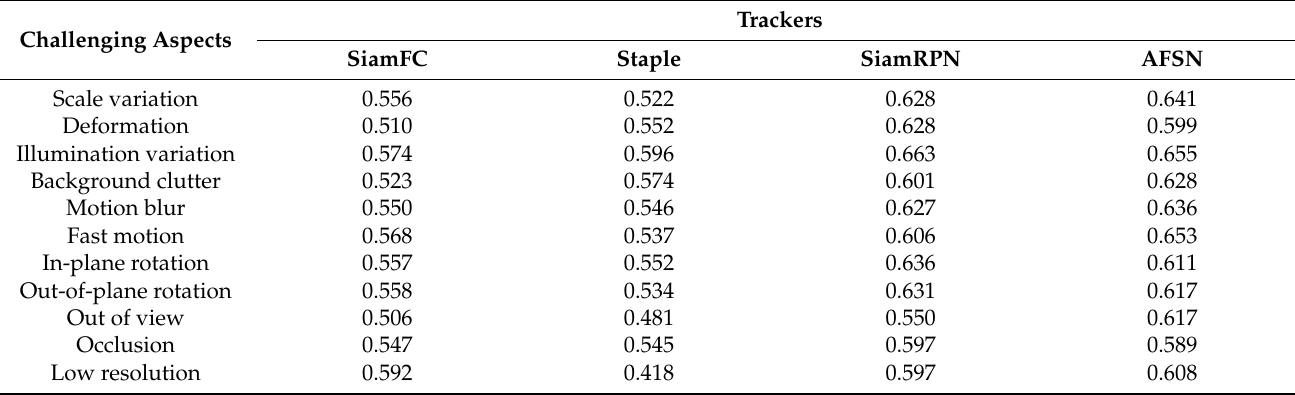
Figure 7. Comparisons on OTB100. ( a ) Success plots and ( b ) precision plots. Our AFSN achieves the best results. AFSN: Anchor-Free Siamese Network; SiamRPN: Siamese Region Proposal Network; SiamFC: Fully-Convolutional Siamese Networks; LCT: Long-term Correlation Tracking; CFNet: Correlation Filter Network; MEEM: Robust Tracking via Multiple Experts Using Entropy Minimization; DSST: Discriminative Scale Space Tracker; KCF: Kernelized Correlation Filter. Table 3. Comparisons on OTB100 with challenging aspects. SiamFC: Fully-Convolutional Siamese Networks; SiamRPN: Siamese Region Proposal Network; AFSN: Anchor-Free Siamese